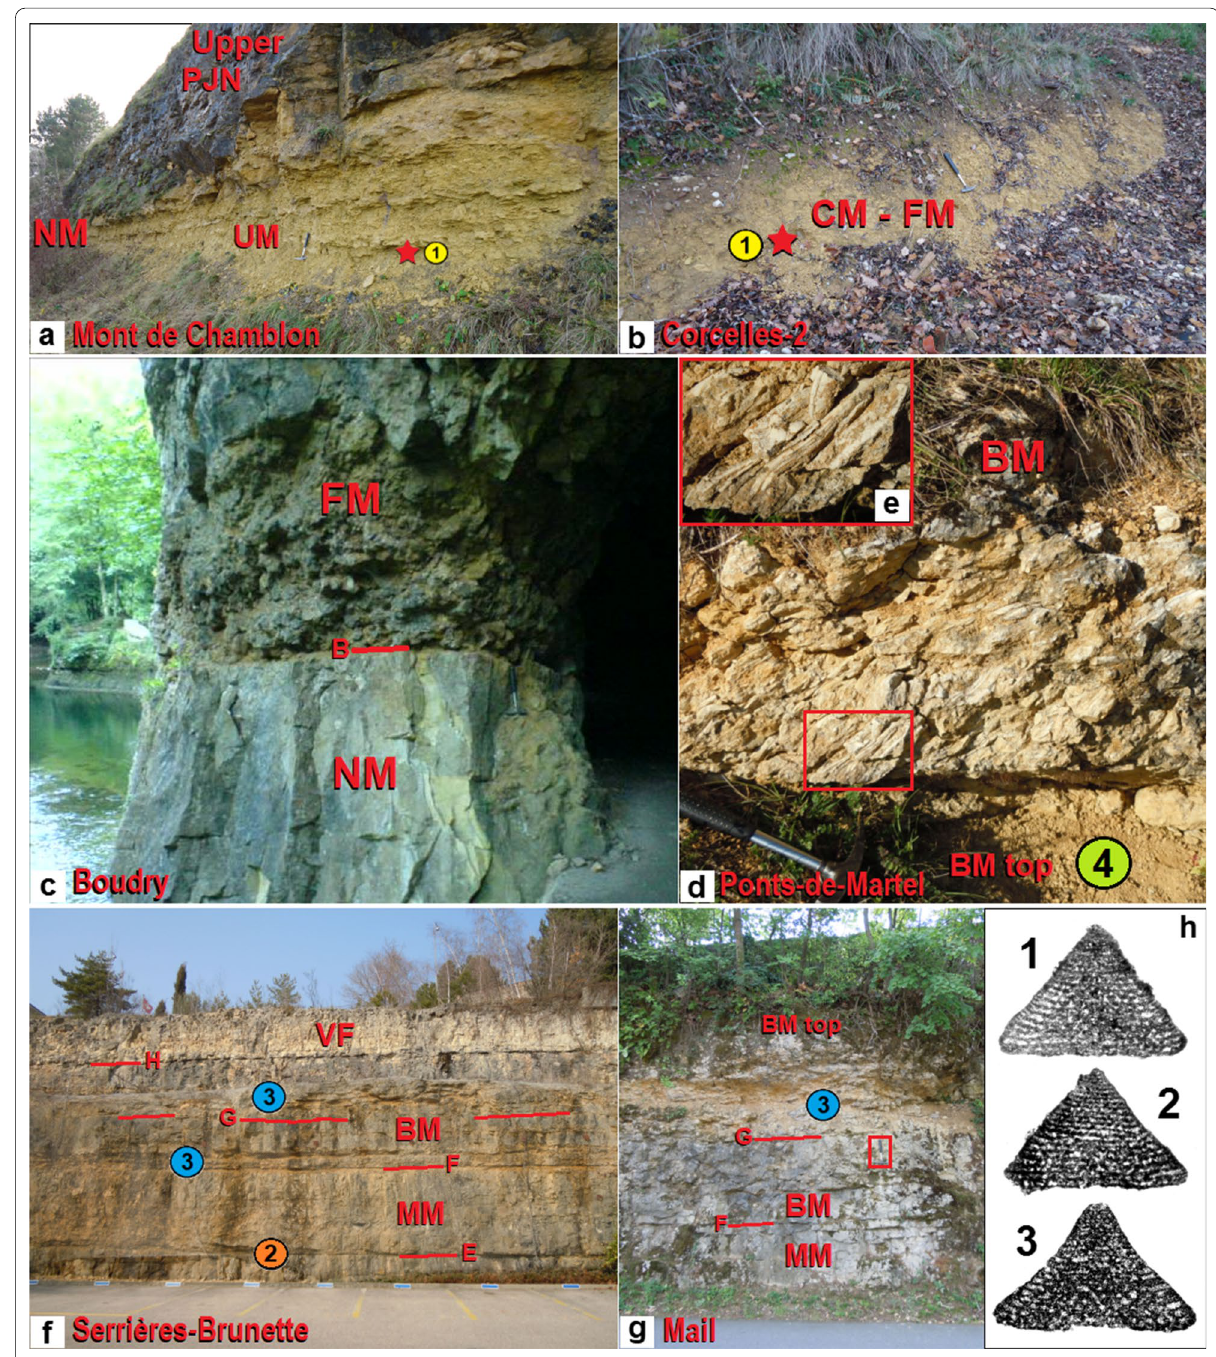
Fig. 7 Sections in the central Jura Mountains ( a : Grand‑Essert Formation of the Vaud Jura; b–g : Saars Formation of the Neuchâtel Jura). a Mont de Chamblon section with late Early Hauterivian Uttins Marls. b Corcelles‑2 section with Early Barremian Corcelles Marls. c Lower Boudry section, latest Hauterivian topmost massive PJN facies (NM) and basal Urgonien Jaune facies (FM) with marly conglomerate (cf. Godet et al., 2010, fig. 10). d , e Ponts‑de‑Martel section, reversed strata of overturned fold with Pachytraga reef ( e : rudists Pachytraga tubiconcha Astre, 1961) and marls with ostracods (below). f Serrières‑Brunette section with large stromatoporoid reef (cf. Remane et al., 1989b). g , h Upper Les Saars‑Le Mail section, historical fossil‑rich site of Le Mail (Desor, 1858; Schaer, 2006) with orbitolinids ( h : axial sections 1–3 of Praedictyorbitolina claveli Schroeder, 1994) and various macrofossils [ Goniopygus peltatus L. Agassiz, 1838; Belbekella lata (d’Orbigny, 1847), stromatoporoids, corals]. Captions: NM: Neuchâtel Member; PJN: Pierre Jaune de Neuchâtel (facies); UM: Uttins Marls (lithostratigraphic bed); FM: Falaises Member; CM: Corcelles Marls (lithostratigraphic bed); MM: Montcherand Member; BM: Bôle Member; VF: Vallorbe Formation; red stars: samples with nannofloras. For the reported discontinuities (B, E, F, G, H) and ostracod assemblages (colored circles 1, 2, 3, 4), see Figs. 10 and 11. The hammer ( a – d ; g : red frame) is 31.5 cm